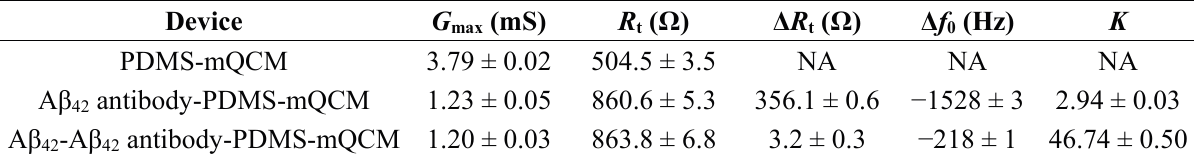
Figure 4. On-line monitoring frequency response for a complete sequence of immobilization of A β 42 antibody and detection of A β 42 on PDMS-mQCM microfluidic system. Table 1. Comparison of equivalent circuit parameters between on the bare and those on modified mQCM in liquid